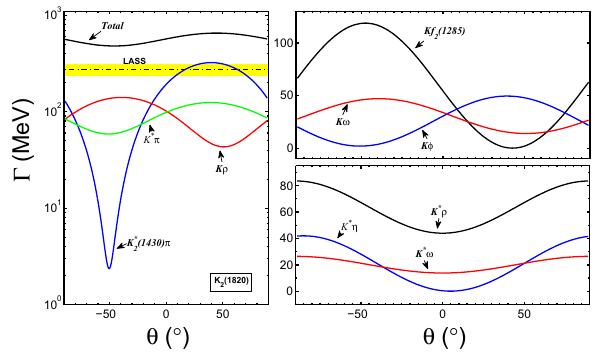
Fig. 7 θ 1 D dependence of the decay width of K 2 ( 1820 ) . Here a dot- dashed line LASS with a yellow band is taken from